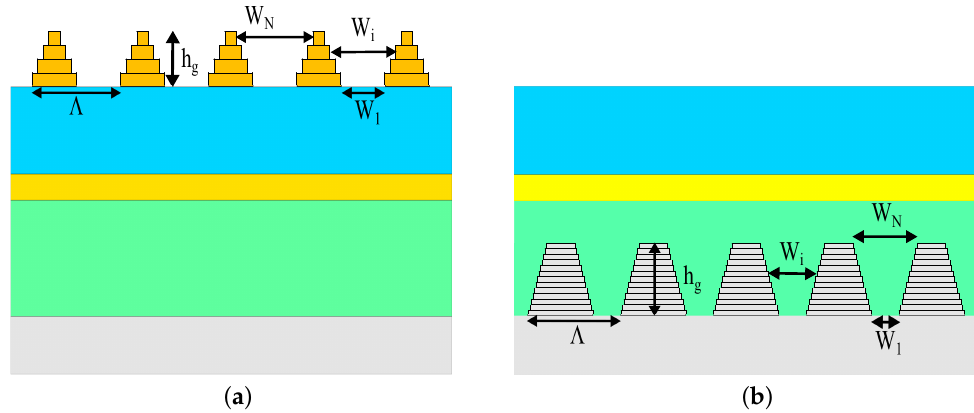
Figure 3. ( a ) Pyramid A structure: a Front 3D-PMMA pyramid-grating layer is placed on the reference solar cell structure. ( b ) Pyramid B structure: a back 3D pyramid-grating layer is integrated at the absorber–aluminum interface of the reference solar cell